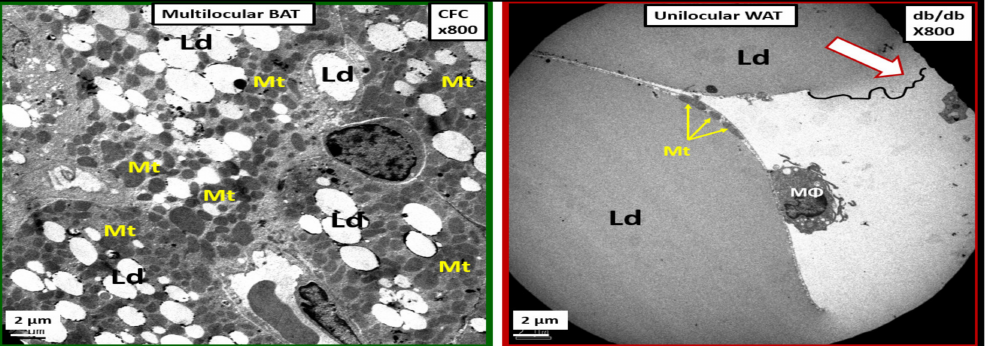
Figure 24. Comparison between multilocular brown adipose tissue (BAT) in control (CFC) perivas- cular adipose tissue (PVAT), which transdifferentiates to unilocular white adipose tissue (WAT) in the obese, insulin resistant, diabetic db/db model. The left-hand panel demonstrates the multilocular BAT in the CFC control models in the descending thoracic aorta PVAT with its multiple mitochondria (Mt). The right-hand panel depicts the unilocular transdifferentiated WAT with the adherence of an inflammatory macrophage (M Φ ) in the diabetic db/db model. Note the rupture of the plasma membrane with leakage of inciting inflammatory lipids into the interstitium (open arrow) that has no Mt and also the thinned small Mt (closed arrows) in the adjacent adipocyte. This image is from the experiment in reference [69]. Ld = lipid droplet.